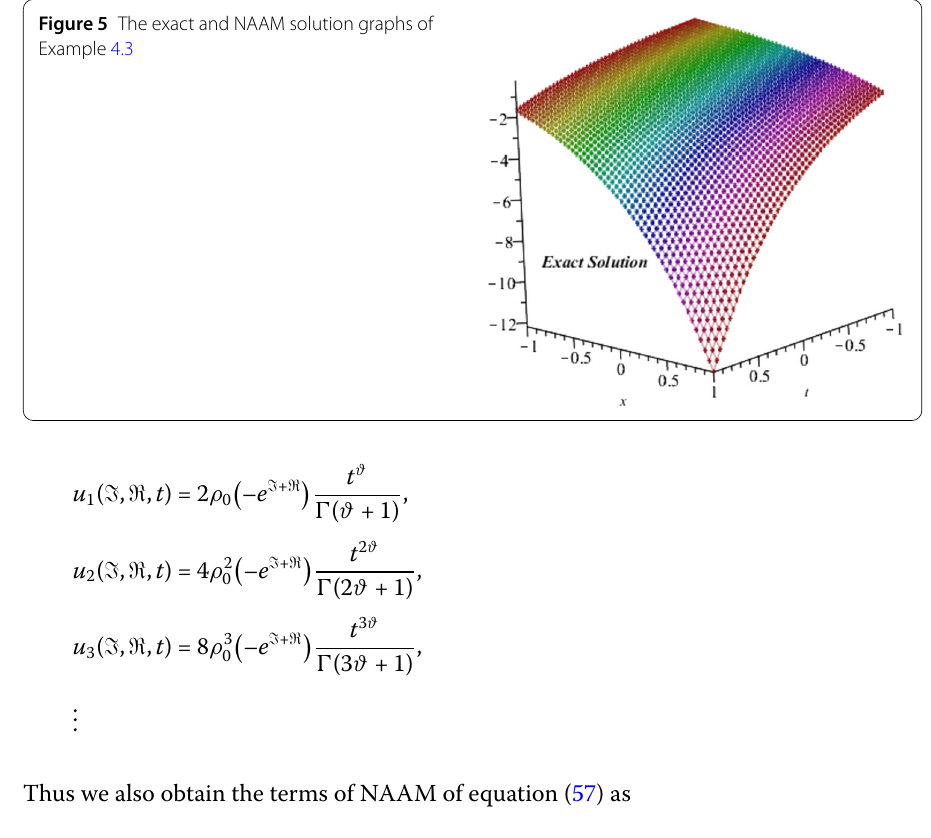
Figure 5 The exact and NAAM solution graphs of Example